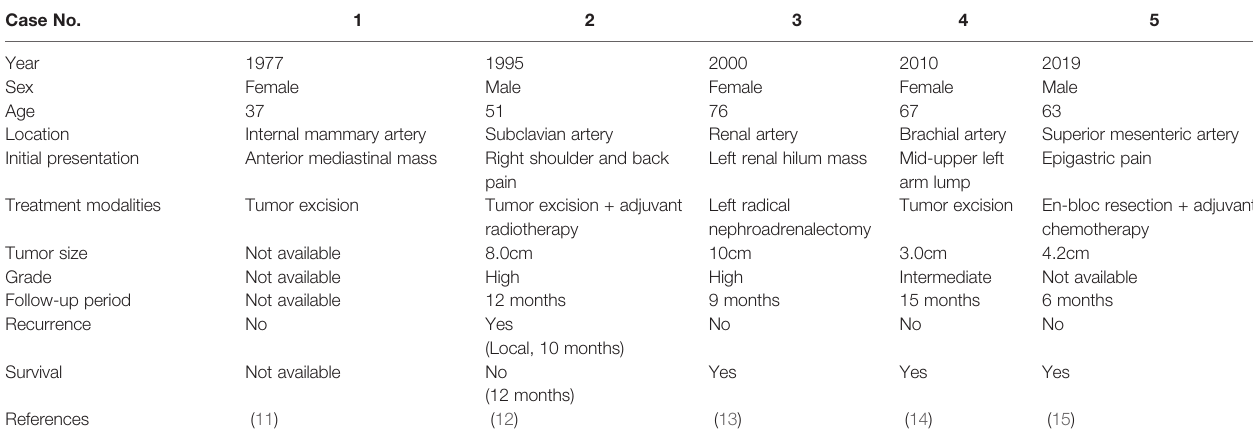
FIGURE 6 | Proliferation suppression of circulating sarcoma cells, more than 80% of growth inhibition, was observed for doxorubicin, eribulin, gemcitabine, olaratumab/doxorubicin combination, and pazopanib. TABLE 1 | Summary of published case reports and case series on rare origin arterial leiomyosarcoma (LMS). Case